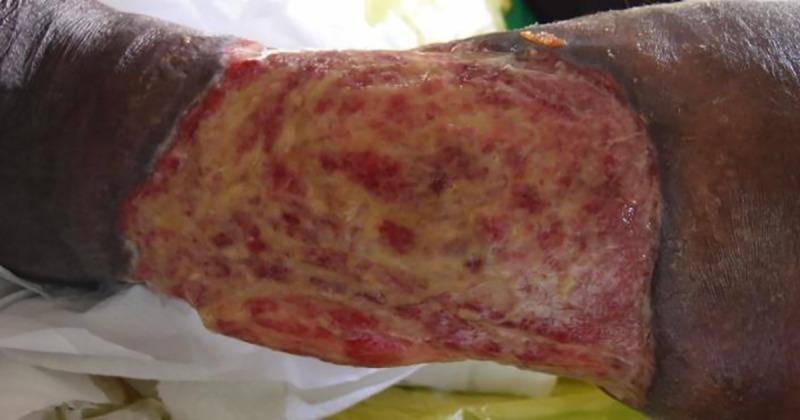
Infected IS2404 PCR positive ulcers on the left leg of patient 003 at the SHC center.